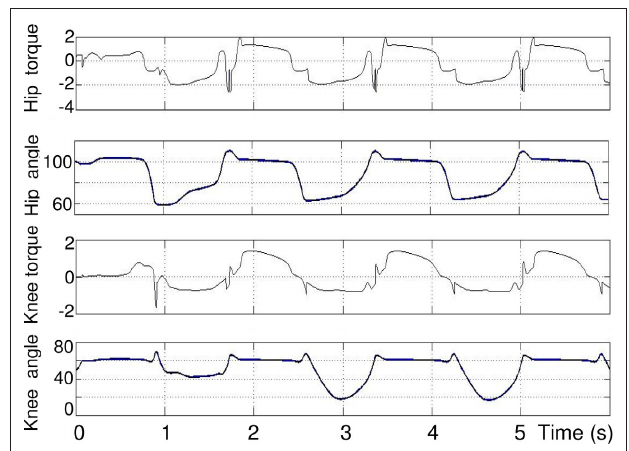
FiguRe 11 | effect of feedback from ground sensor gCS on the rhythmic activity of the leg. Top: distance reached by the hip on the rail. Bottom: speed of the hip. Dashed lines: with GCS. Solid lines, without.